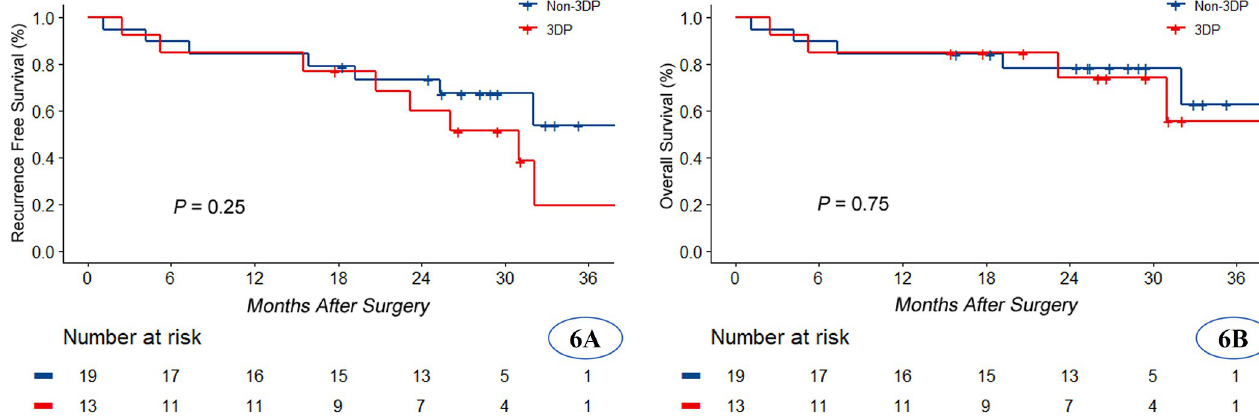
Fig 6. Recurrence-free survival (RFS) and overall survival (OS) analysis between the 3DP and non-3DP groups of patients with HCC.